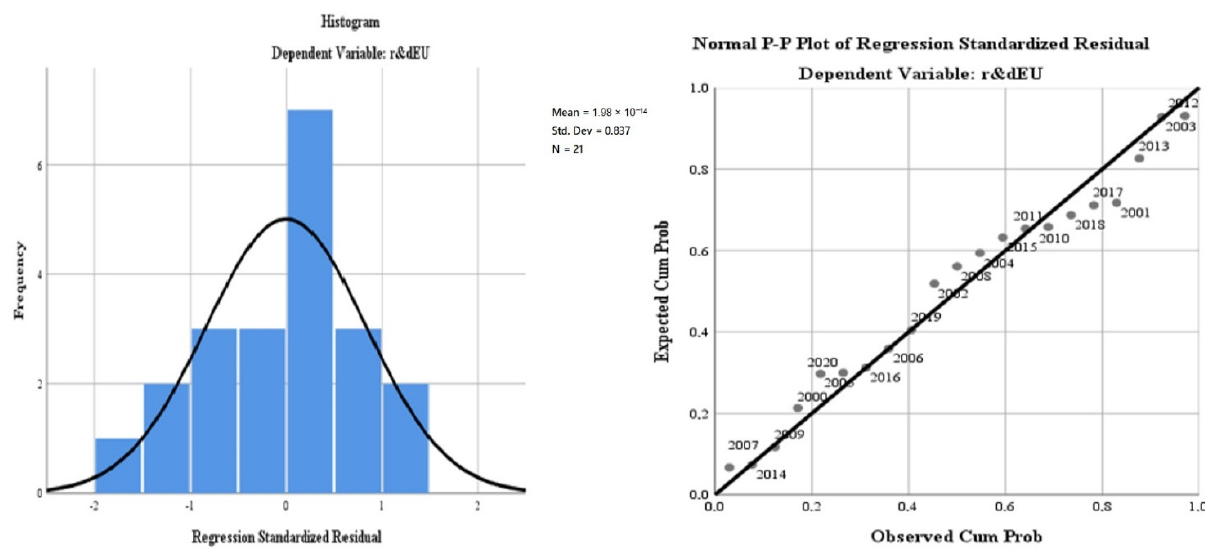
Figure 4. Regression analysis for the EU27 during 2000–2020. Source: Data operated under IBM- SPSS 25 (IBM, Armonk, NY, USA).